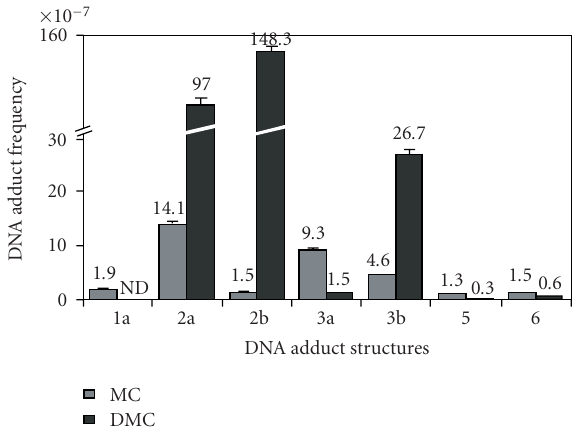
Figure 4: Frequencies of DNA adducts formed in MCF-7 human breast cancer cells treated with 10 μ M MC (gray bars) or 10 μ M DMC (black bars) for 24 hours under aerobic conditions. The individual frequency values of the bars are indicated above the bar error limits. Error limits are shown in % relative standard deviation units. (Reproduced with permission from the reference in Figure